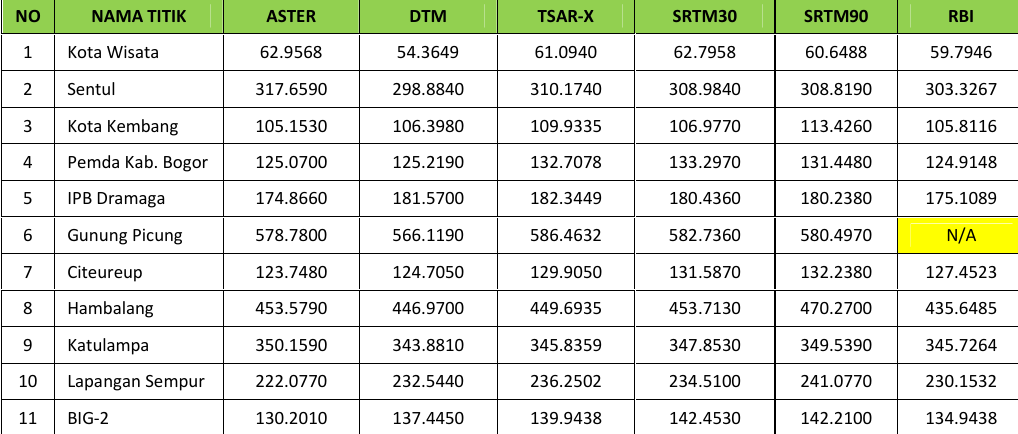
Table 5. Z-value of all test points in each DEM